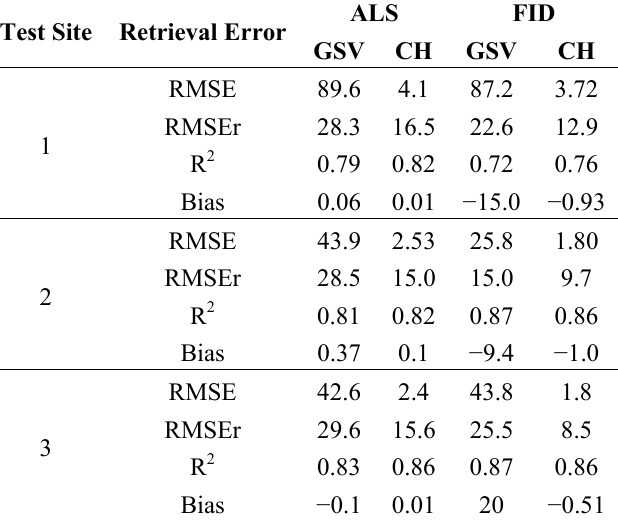
Table 3. CH and GSV retrieval error when using multi-temporal PALSAR SAR/INSAR as well as Landsat data as predictors in randomForest and ALS-based GSV and CH estimates as response variables. The accuracies refer to the comparison with (1) ALS-based estimates of CH and GSV and (2) the inventory data